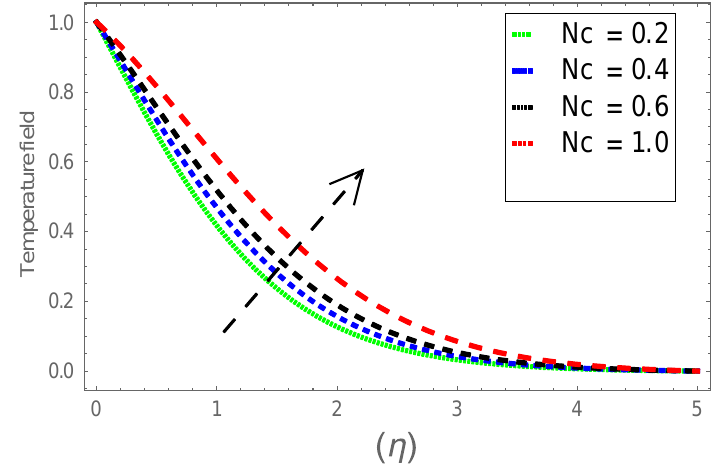
Coatings 2021 , 11 , x FOR PEER REVIEW